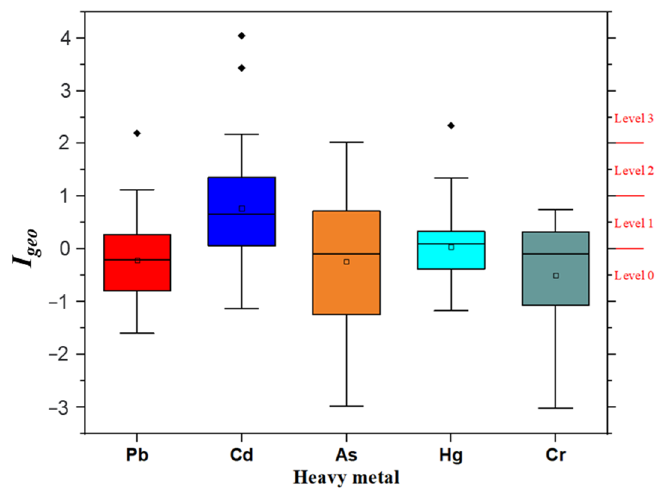
Figure 5. The I geo levels of five heavy metals in bamboo shoots soil of the research areas.